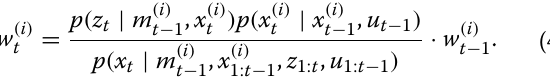
Formulation of RBPFs